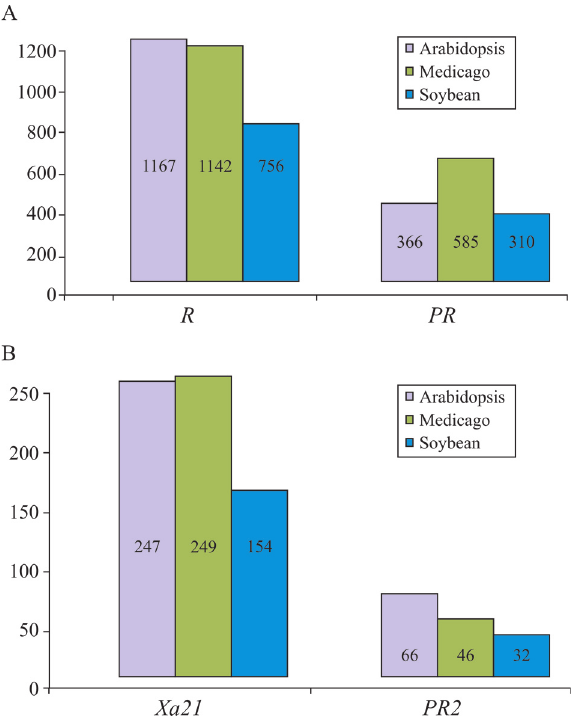
Figure 3 - Distribution of R and PR genes in soybean, Medicago and Arabidopsis (A). Distribution of Xa21 and PR-2 in soybean, Medicago and Arabidopsis (B). Numbers of matches for each gene category are shown inside the